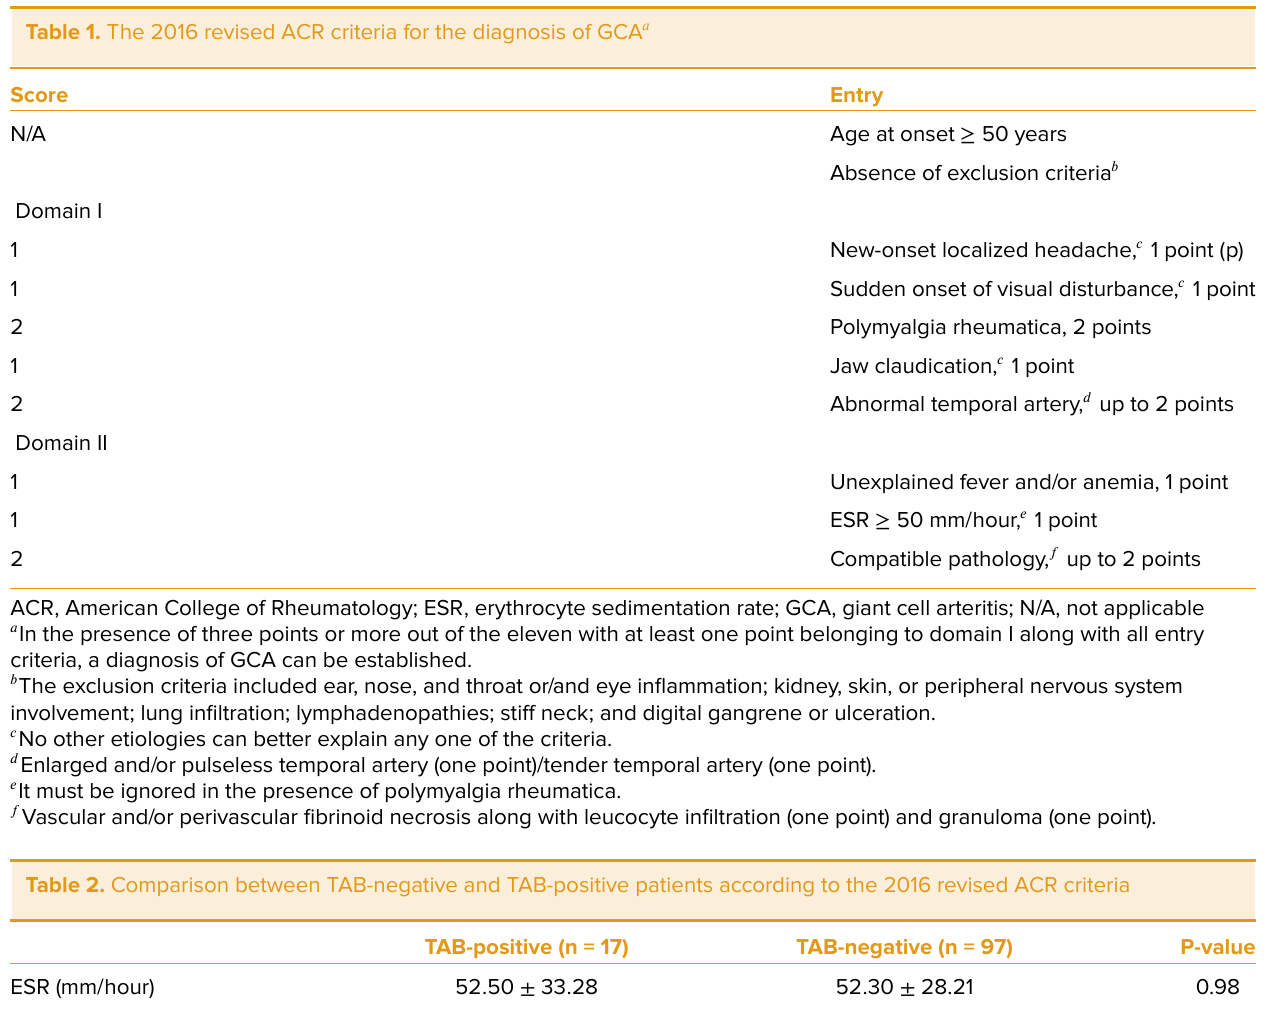
Table 1. The 2016 revised ACR criteria for the diagnosis of GCA 𝑎